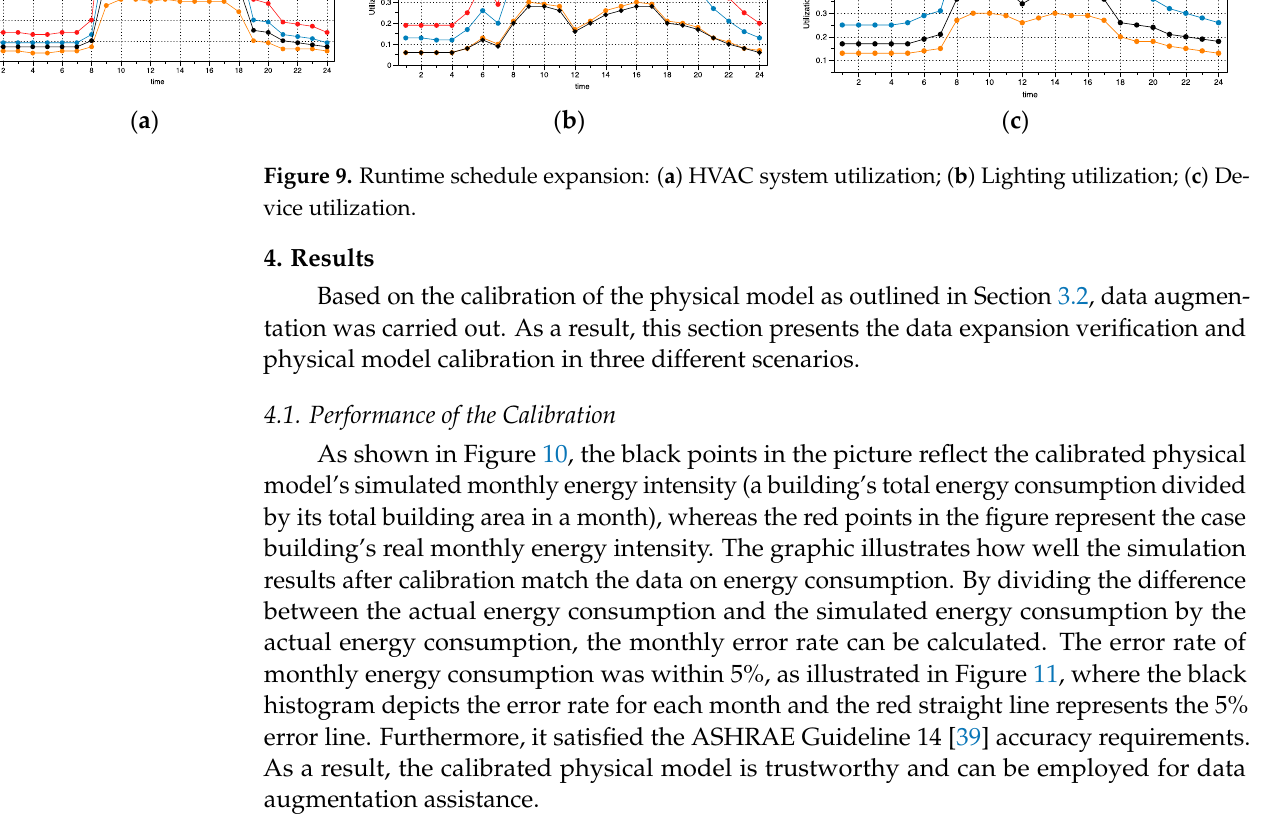
Figure 11. Error distribution of monthly total energy consumption. 4.2. Performance of Data Augmentation This study specified three typical situations with major changes in routines for veri- fication to check the performance of data augmentation, and the scenarios did not arise in the historical range. The three scenarios were created as follows: • Scenario 1: Each item’s utilization rate was highest simultaneously.